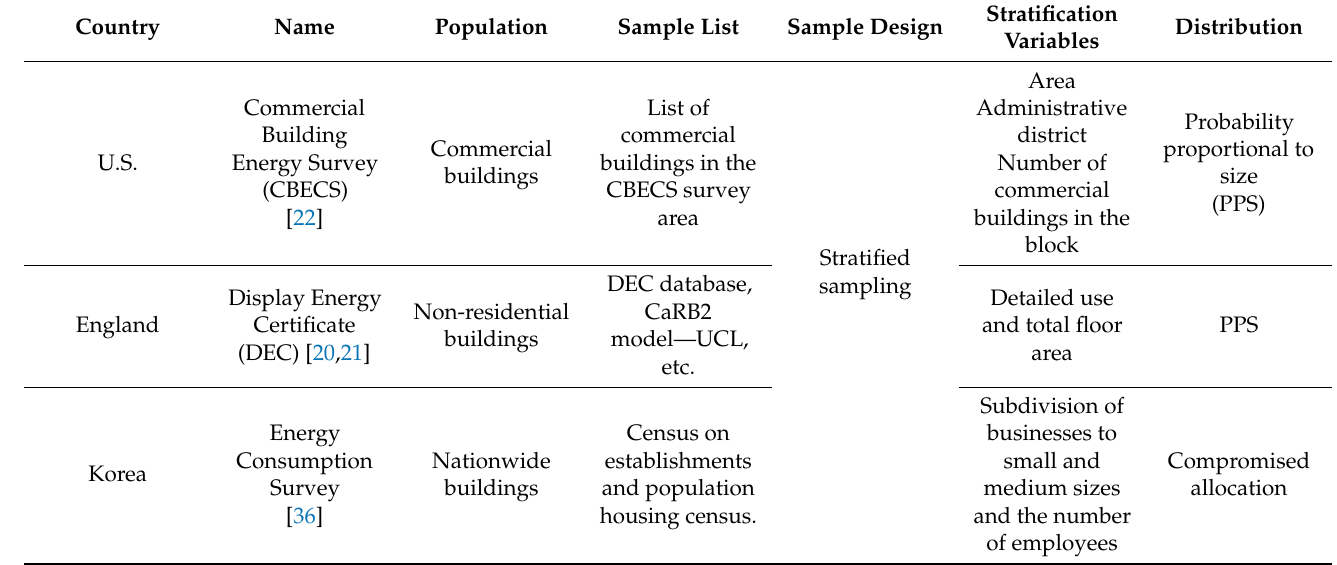
Table 3. Sampling methods in surveys or systems by